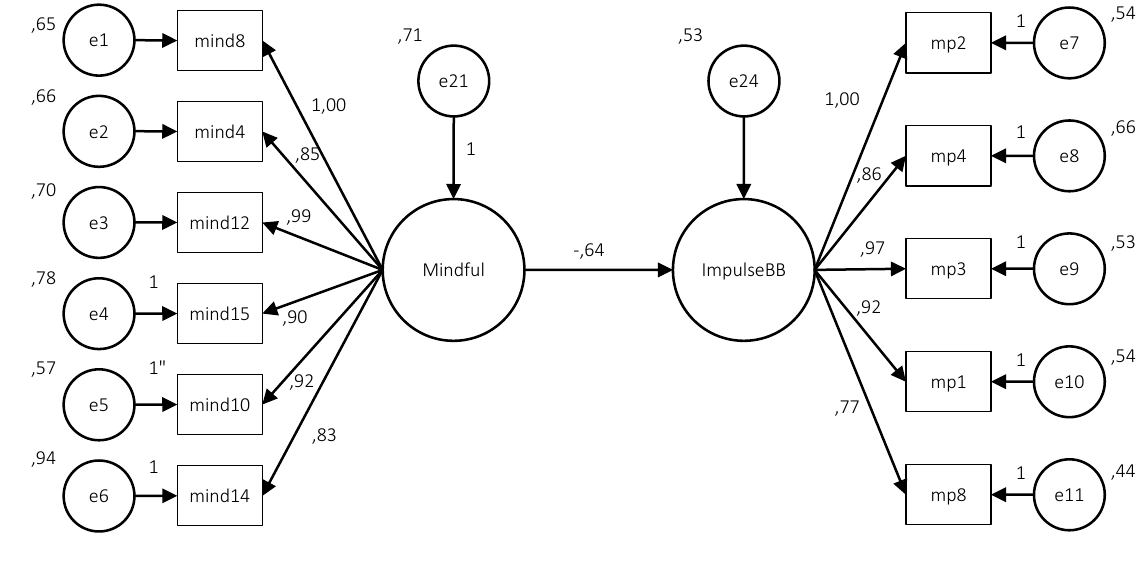
Figure 2. The standardized path diagram of the research model